Question: What type of chart is this?
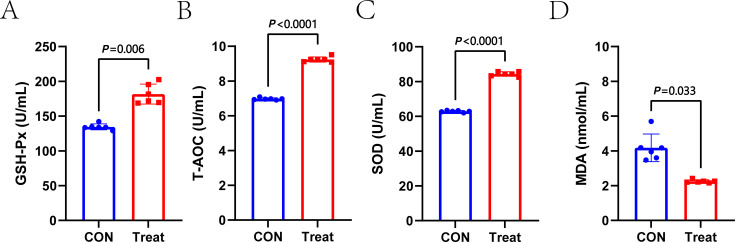
Answer: bar